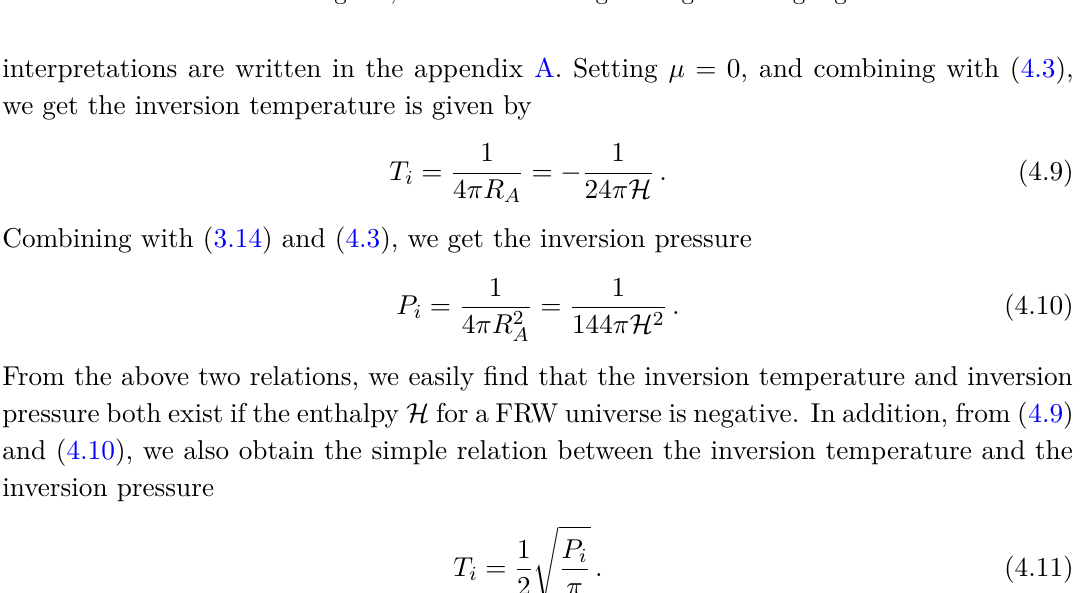
Figure 2 . The isenthalpic curves for a FRW universe have been plotted with different values of H , while the monotonous black line is the inversion curve. These isenthalpic curves are separated by the inversion curve into two regions, i.e. the left cooling and right heating